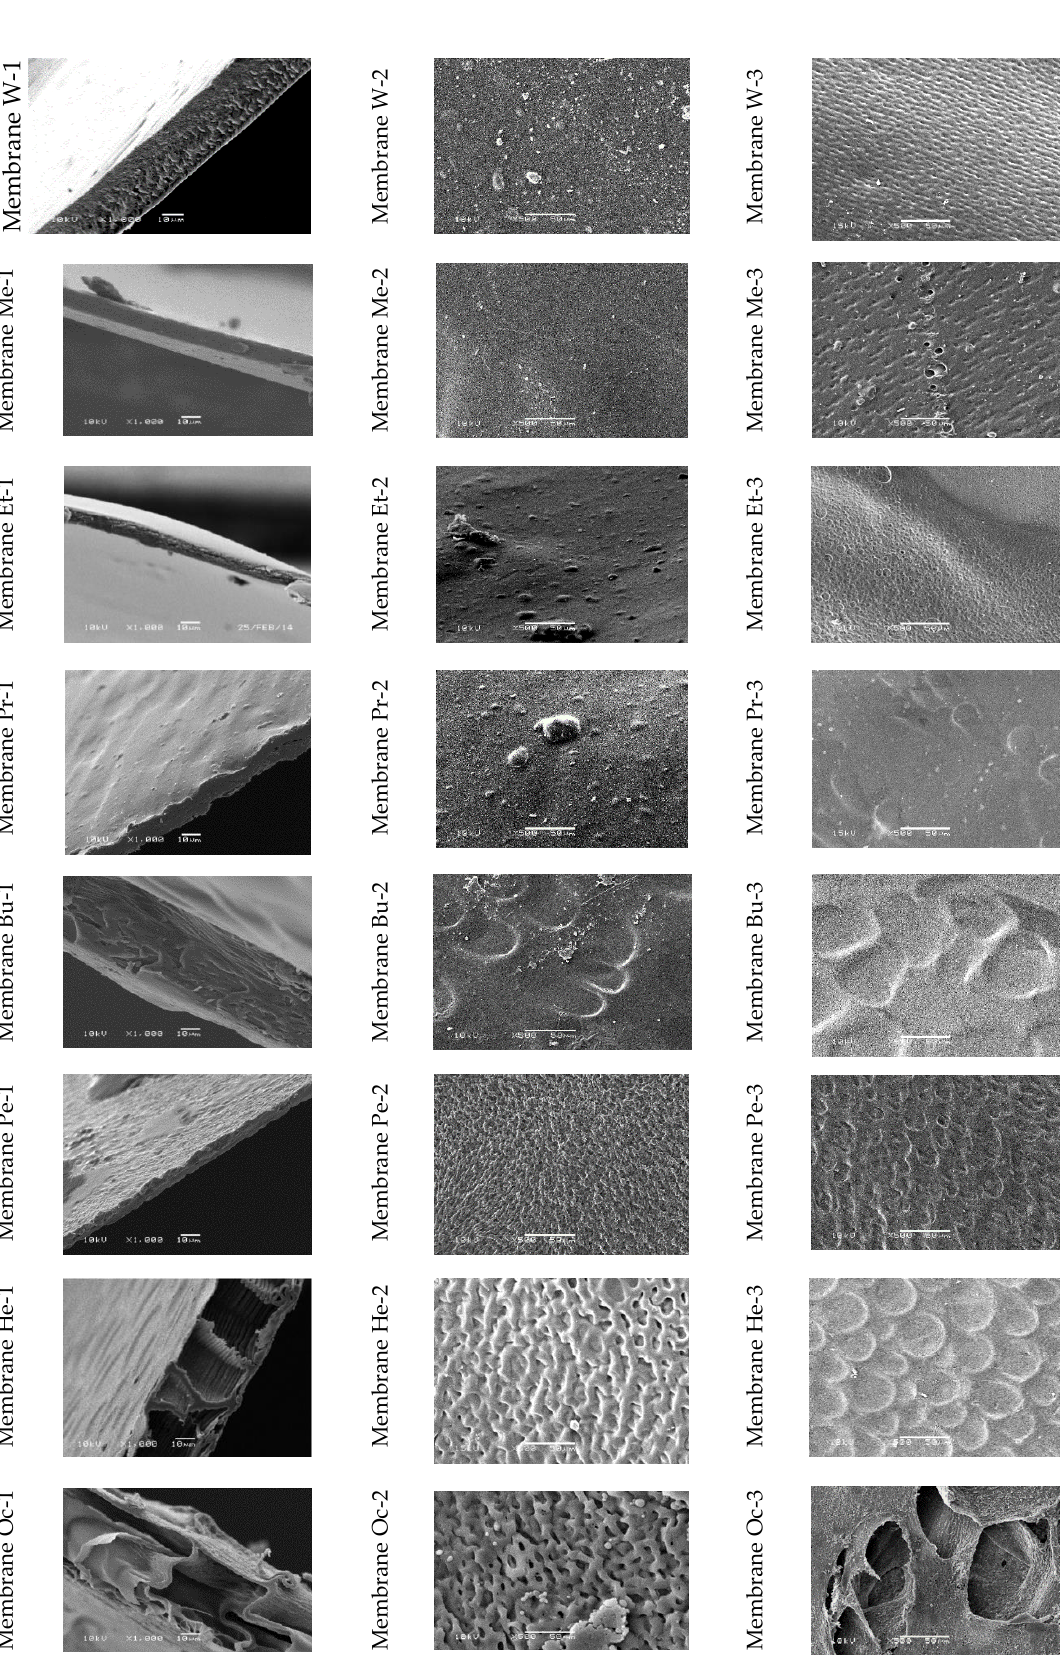
Figure 10. SEM images for cellulose membranes: ( 1 ) cross-section; ( 2 ) skin layer; ( 3 ) bottom layer.